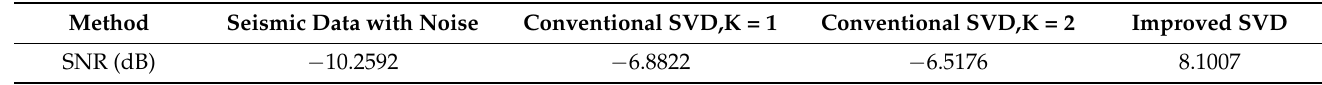
Table 3. SNR comparison of denoised results from different methods.